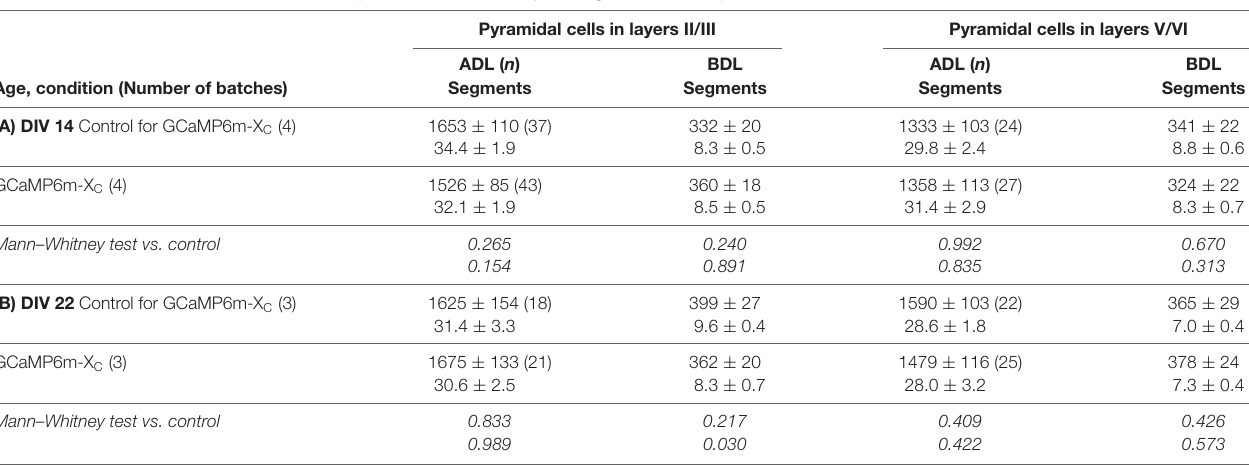
Segments Segments